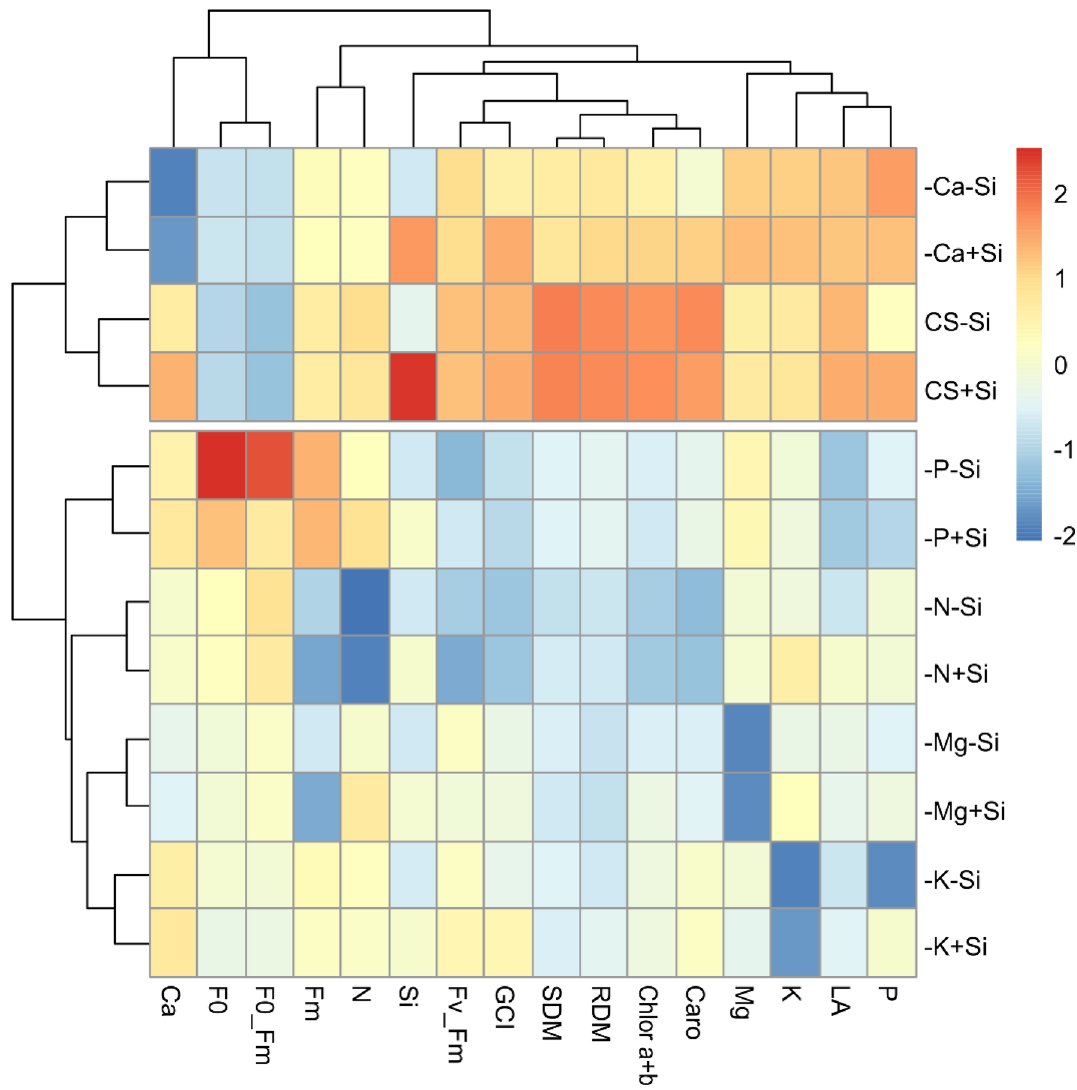
Figure 9. Heatmap built to demonstrate the relationship between treatments and evaluated variables. The package used of R to create this Figure was d3heatmap (v0.4.0, https:// cran.r- proje ct. org/ web/ packa ges/ d3hea tmap/ index.